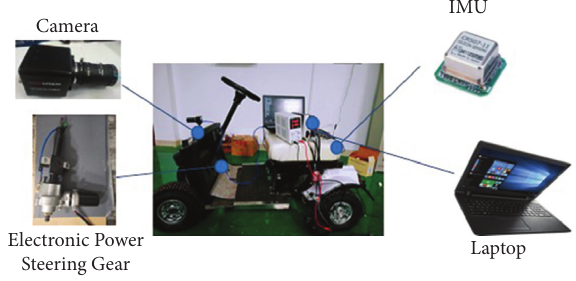
Figure 15: Experimental